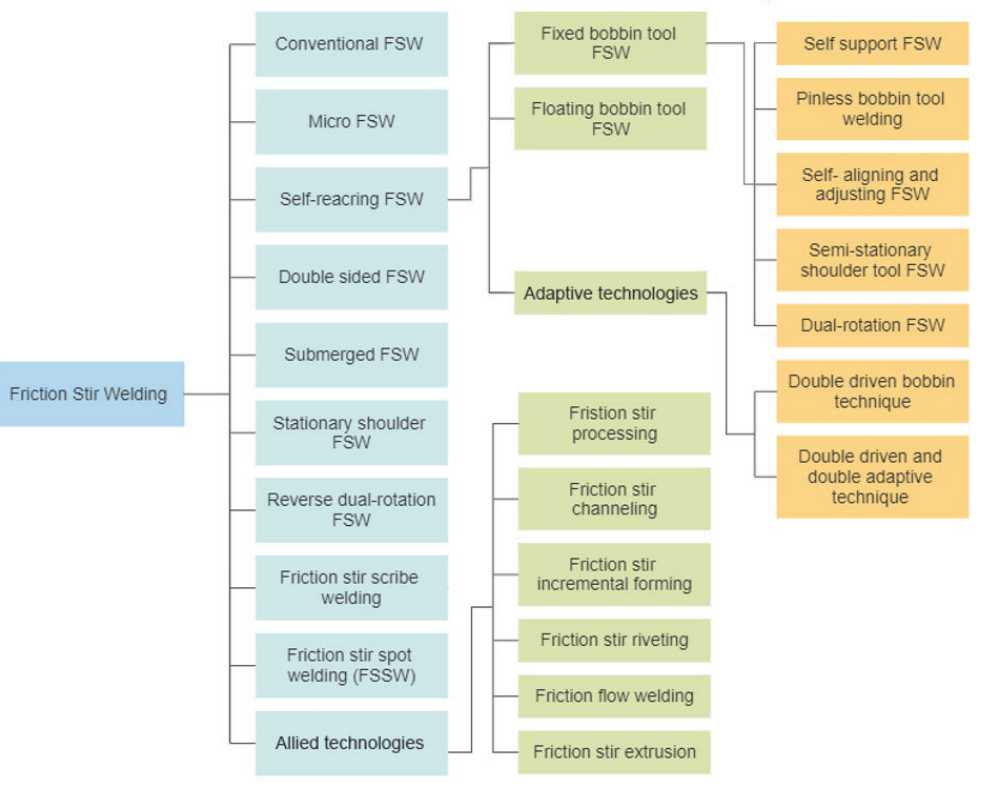
Figure 1. Schematic classification of friction stir welding processes, adapted with permission from [18]. 2020, Danka Labus